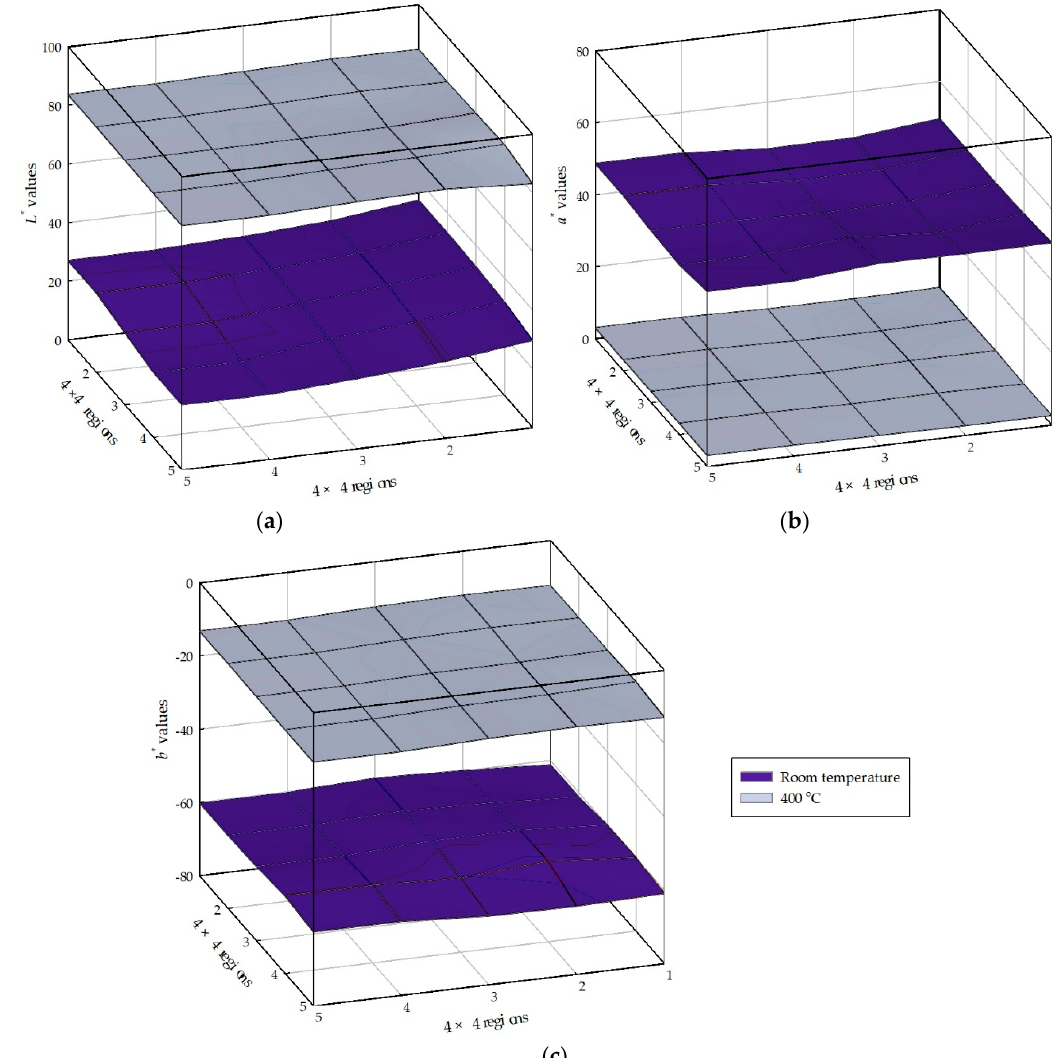
Figure 12. Color intensities in 4 × 4 regions on the surface: ( a ) L * values; ( b ) a * values; ( c ) b * values.